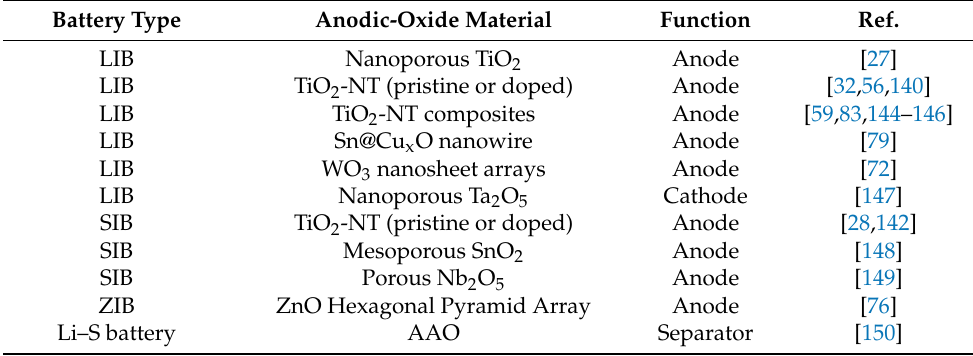
Table 6. Anodic oxides applied as a component of ion-batteries. Battery Type Anodic-Oxide